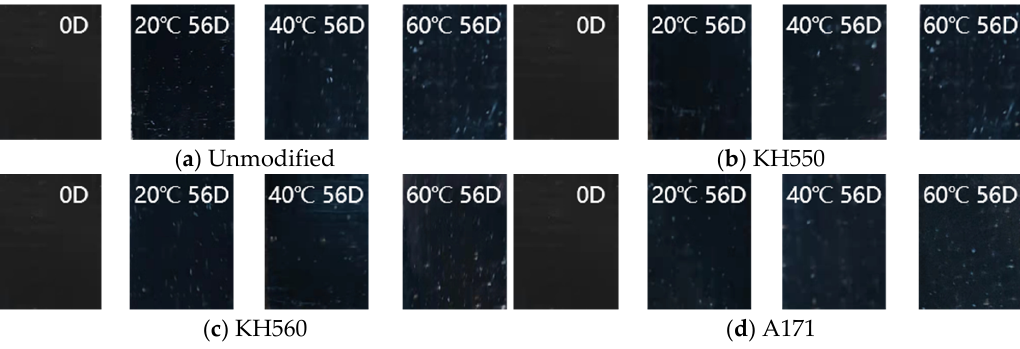
Figure 7. Appearance changes in a water environment.